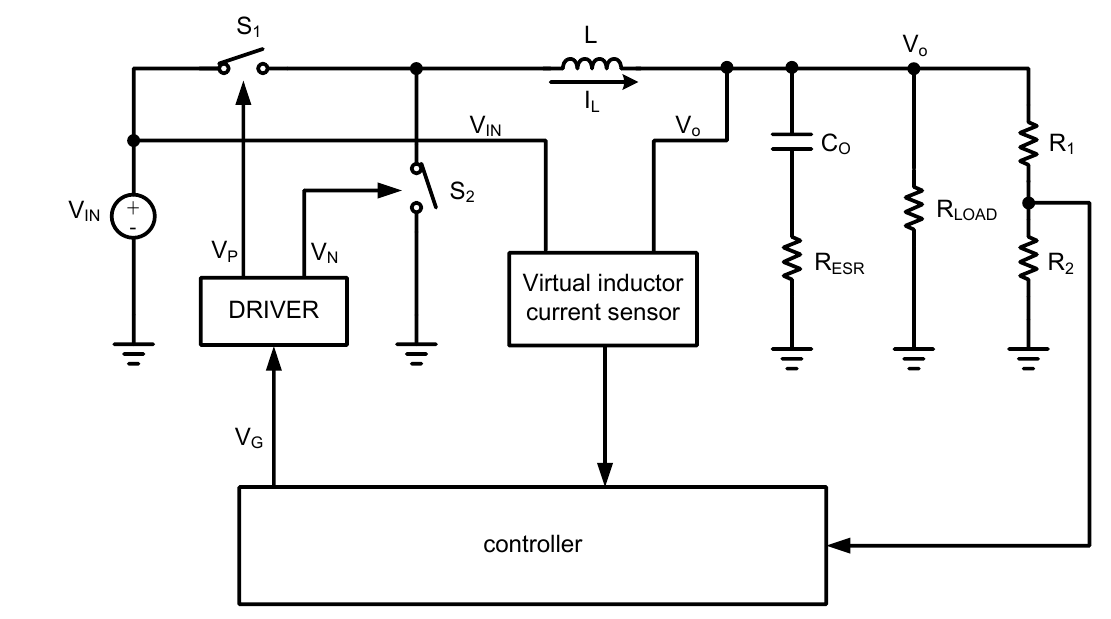
Figure 1. Buck topology with a virtual inductor current sensor.